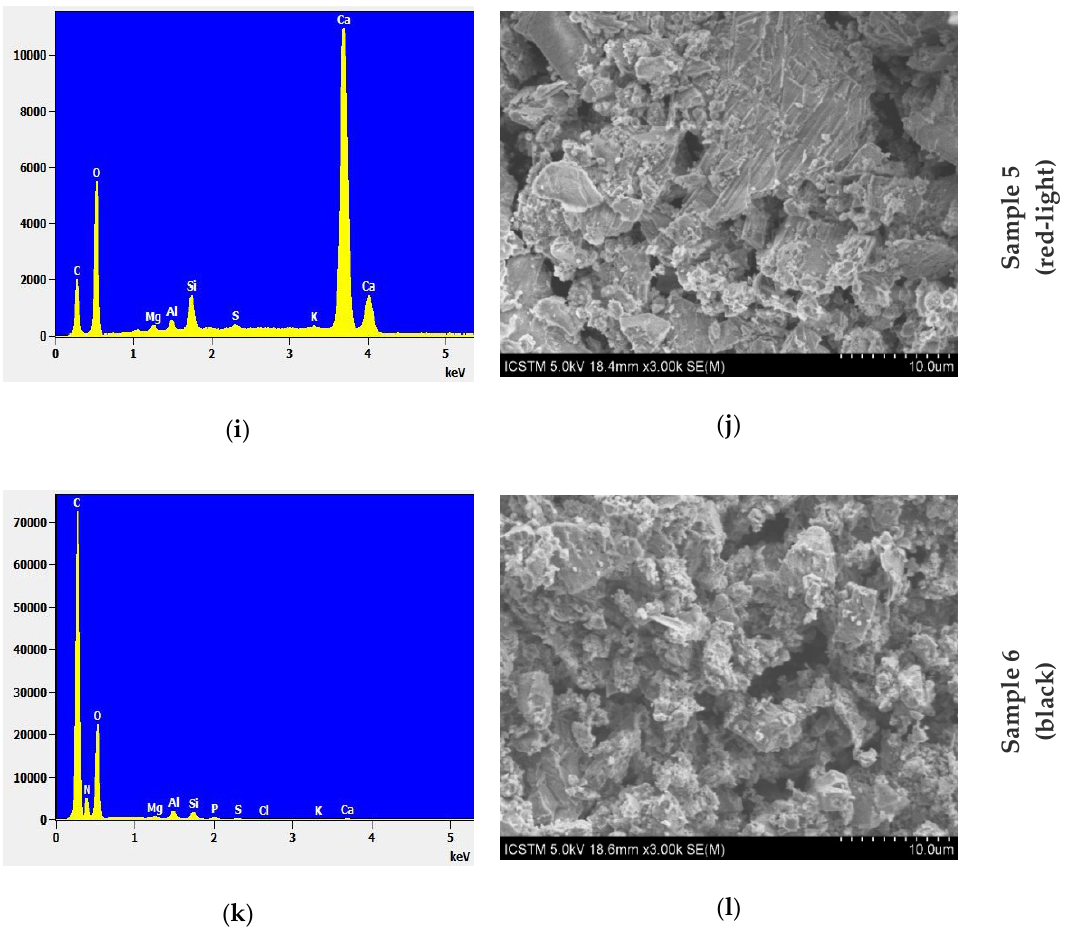
Figure 3. The EDS patterns of the mosaic samples—the main elements composition are labeled ( a , c , e , g , i , k ); FE-SEM images of the mosaic samples recorded at Vacc = 5 kV, WD = 18.4–18.7 mm, × 3000 magnification ( b , d , f , h , j , l ).